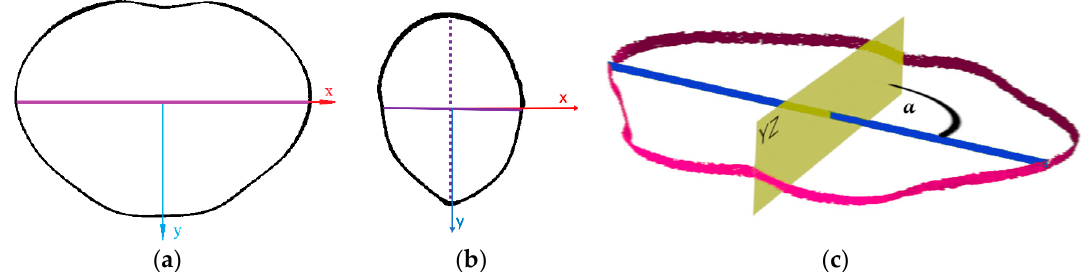
Figure 7. Two possible calculated surfaces, not requiring rotation ( a ) with corresponding 3D view ( c ), and requiring rotation ( b ). Best-fit line is represented by purple solid lines in ( a , b ) and blue line in ( c ). Reoriented dotted line is shown in ( b ). Calculation of angle α based on sagittal plane (YZ, yellow) and best-fit line (blue) from slice points (purple) is presented in ( c ).